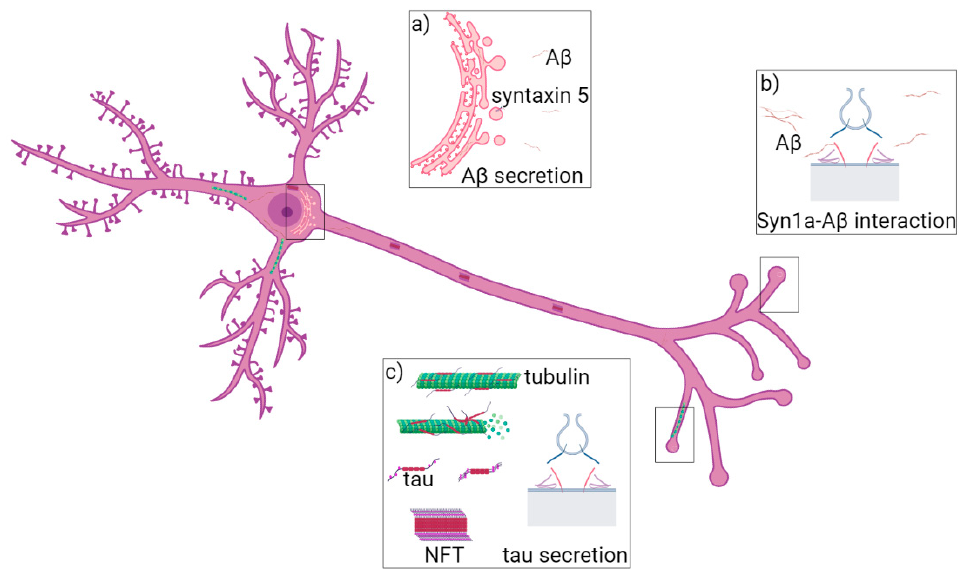
Figure 1. Role of syntaxin-5, syntaxin-1a and VAMP8 in AD. ( a ) Syntaxin-5 (violet) regulates membrane fusion at ER (pink) and it is responsible for A β 42 peptide (yellow) accumulation. ( b ) Syntaxin-1a (red) interacts with A β monomers and oligomers (from yellow to brown), which block the SNARE complex formation and exocytosis. ( c ) VAMP8 (blue) is localized at vesicles fusing to the PM and regulates tau secretion.